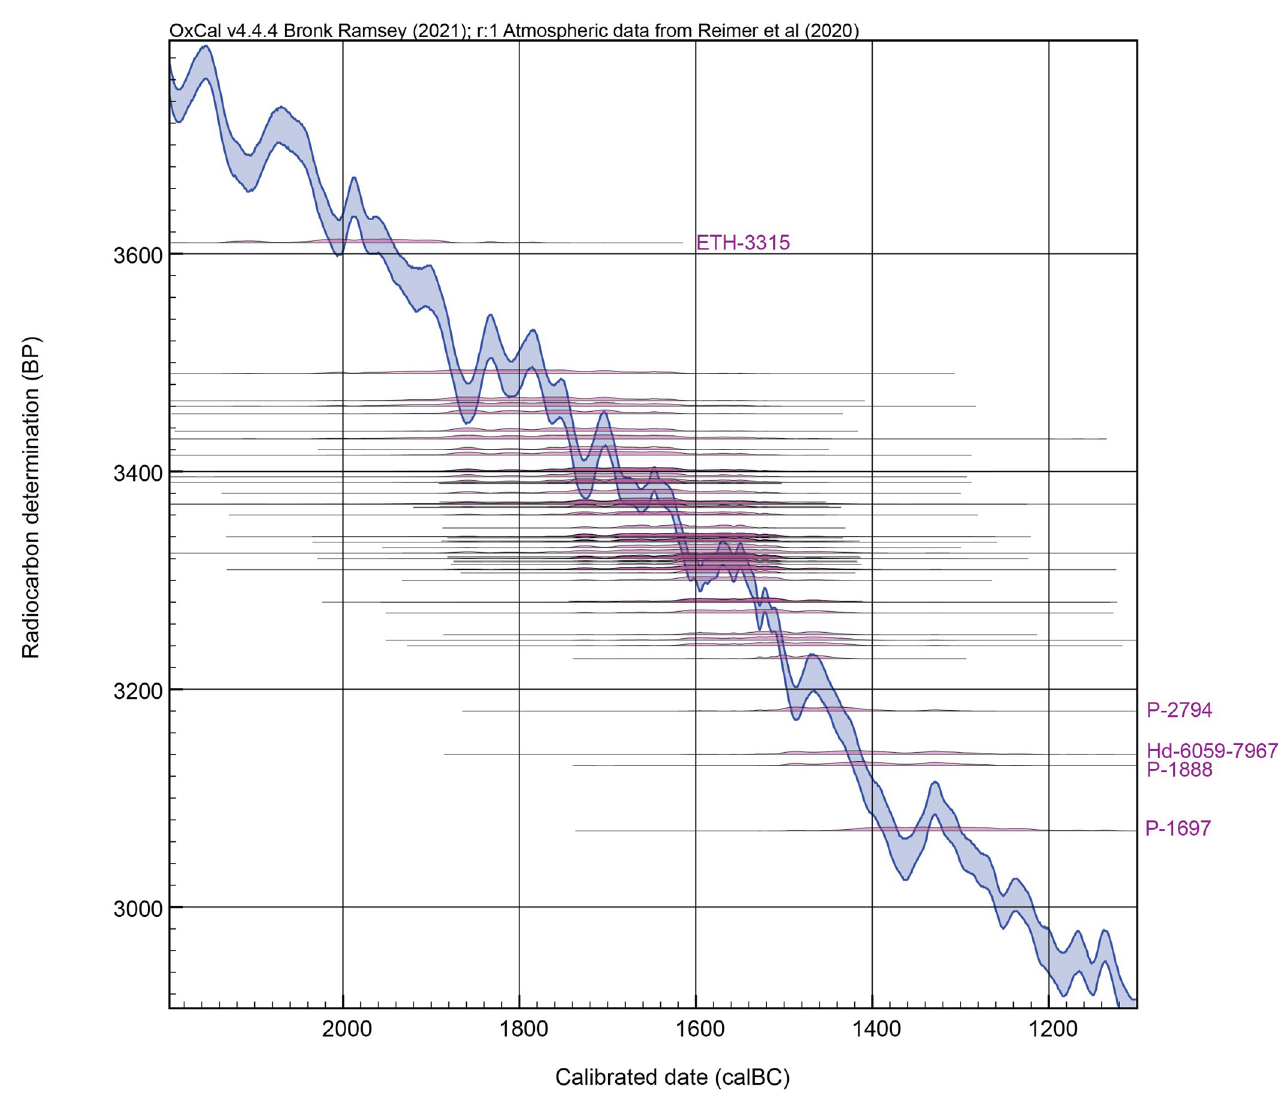
Fig 4. Calibrated calendar probability distributions for each of the dates in dataset (d) from [57] using [41]. As indicated, four of the dates seem visibly too recent; and one date appears substantially too old.